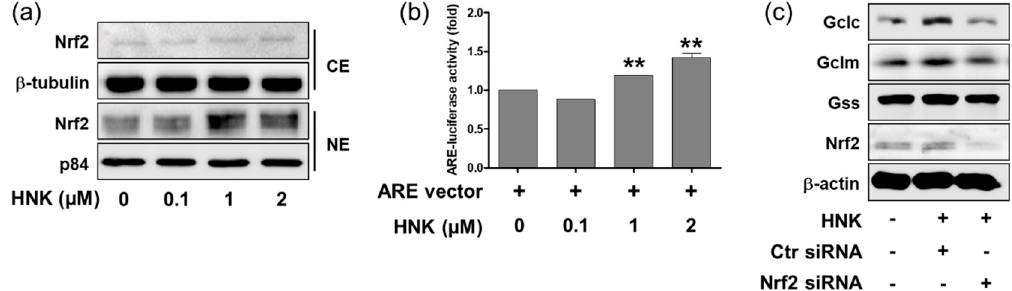
Figure 3. Honokiol increases nuclear translocation Nrf2 and ARE ‐ luciferase activity in HK ‐ 2 cells. ( a ) Cells were treated with honokiol (0, 0.1, 1, or 2 μ M) for 4 h and the cytosolic and nuclear fractionation were extracted and subjected to Western blot analysis. Nrf2 protein levels were normalized to those of β‐ tubulin and p84 in cytosolic and nuclear fractions, respectively. ( b ) Cells were transiently transfected with ARE ‐ luciferase plasmid (1 μ g) for 24 h, and treated with honokiol (0, 0.1, 1, or 2 μ M) for 4 h. The ARE ‐ luciferase activity was measured using a luciferase reporter assay system. ( c ) Cells were transiently transfected with control siRNA or Nrf2 ‐ specific siRNA (50 nM) for 24 h and treated with honokiol (2 μ M) for 12 h. Then, cell lysates were subjected to Western blot analysis using anti ‐ Gclc, anti ‐ Gclm, anti ‐ Gss or anti ‐β‐ actin antibodies. The + and − indicate the presence or absence of each treatment. Values are expressed as the means ± S.E.M. of three independent experiments. ** p < 0.01 significant compared with the vehicle control.